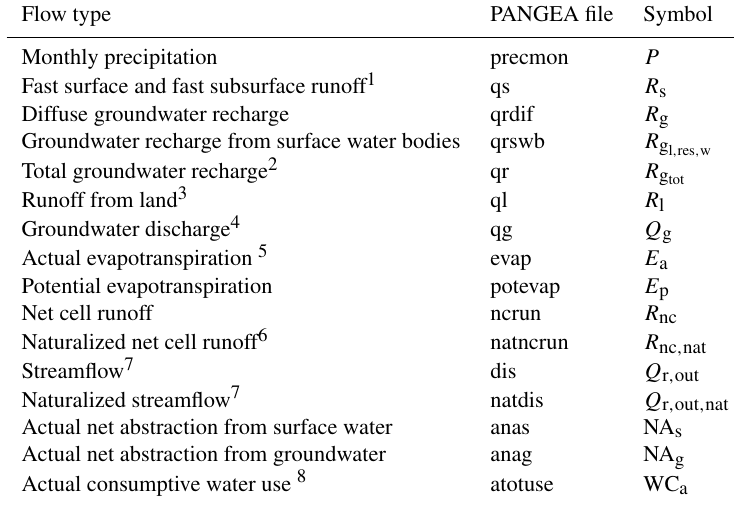
Table 2. Standard WaterGAP output variables: flows. Units arekgm − 2 s − 1 (mme . w . h . s − 1 ), except for Q r , out and Q r , out , nat , which are in m 3 s − 1 . Temporal resolution is